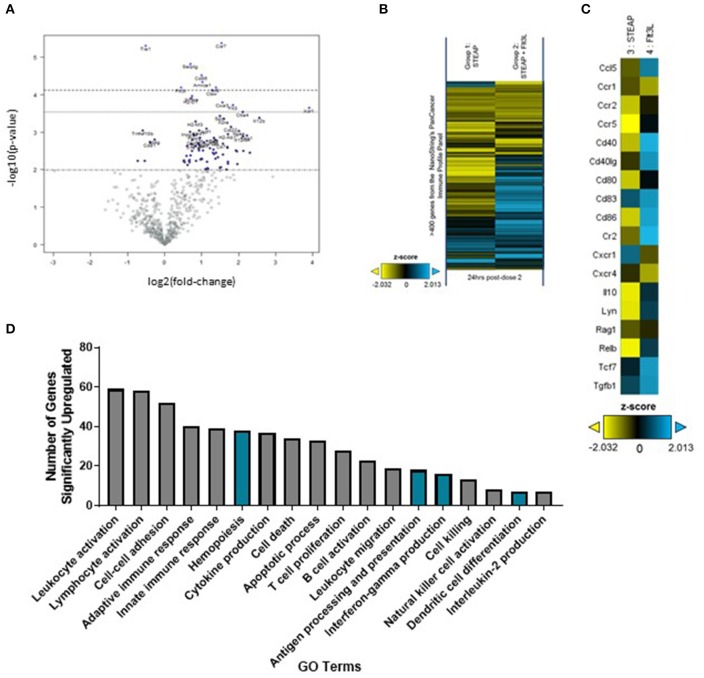
Flt3L-Fc promotes dendritic cell signaling at the site of administration. Mice were immunized weekly and the TA muscle was harvest 24 h post-dose 2. (A) Volcano plot analysis of differentially expressed genes at post-dose 2. (B) Heatmap depicting global differences in gene expression between treatment groups, following the second immunization. (C) Heatmap of DC function and activation genes. (D) Biological processes significantly upregulated by Flt3L-Fc as indicated by DAVID Gene Ontology (GO) terms. Pathways specifically associated with dendritic cells are highlighted in blue.